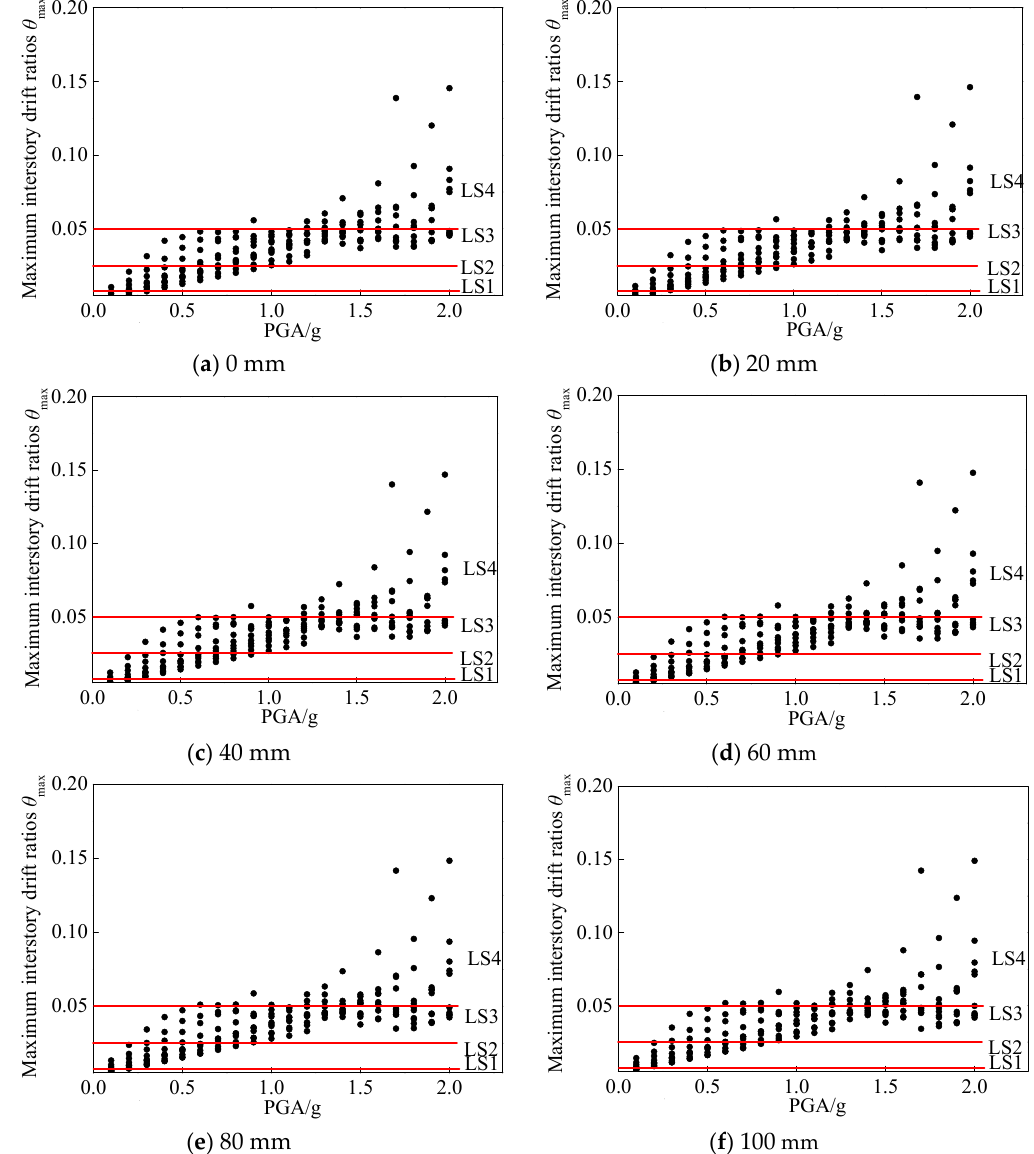
Figure 4. Relationship between the structural demand and PGA of Zone II.